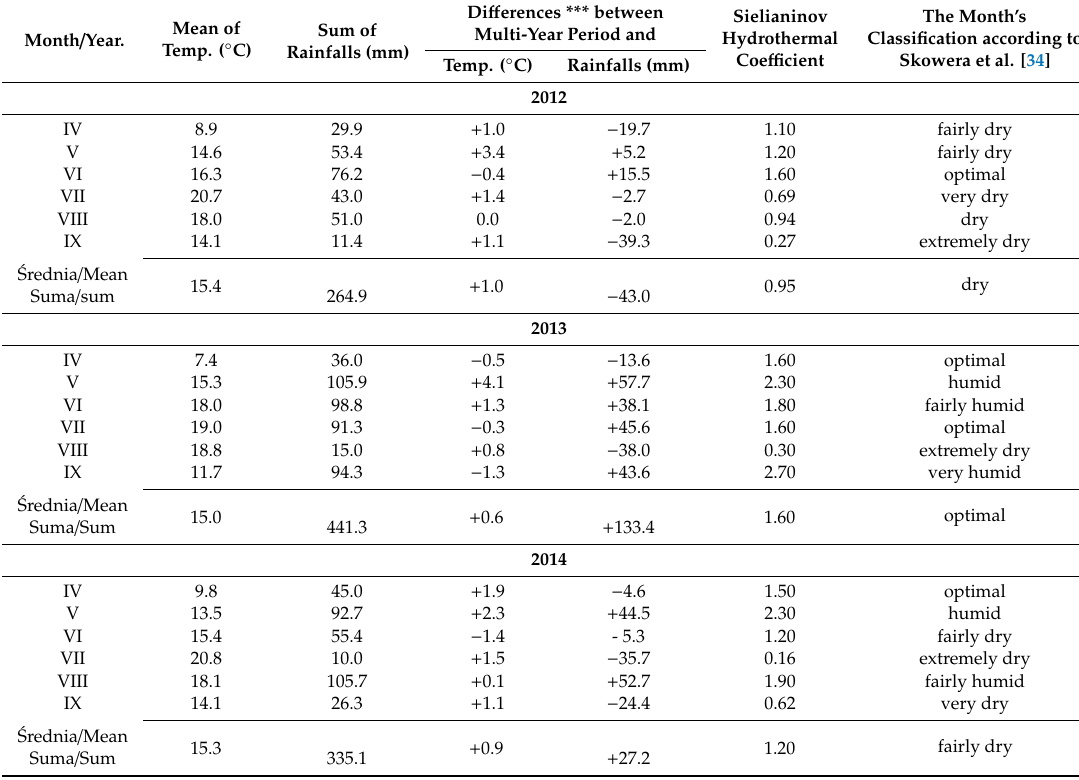
Table 4. Weather conditions during potato growing